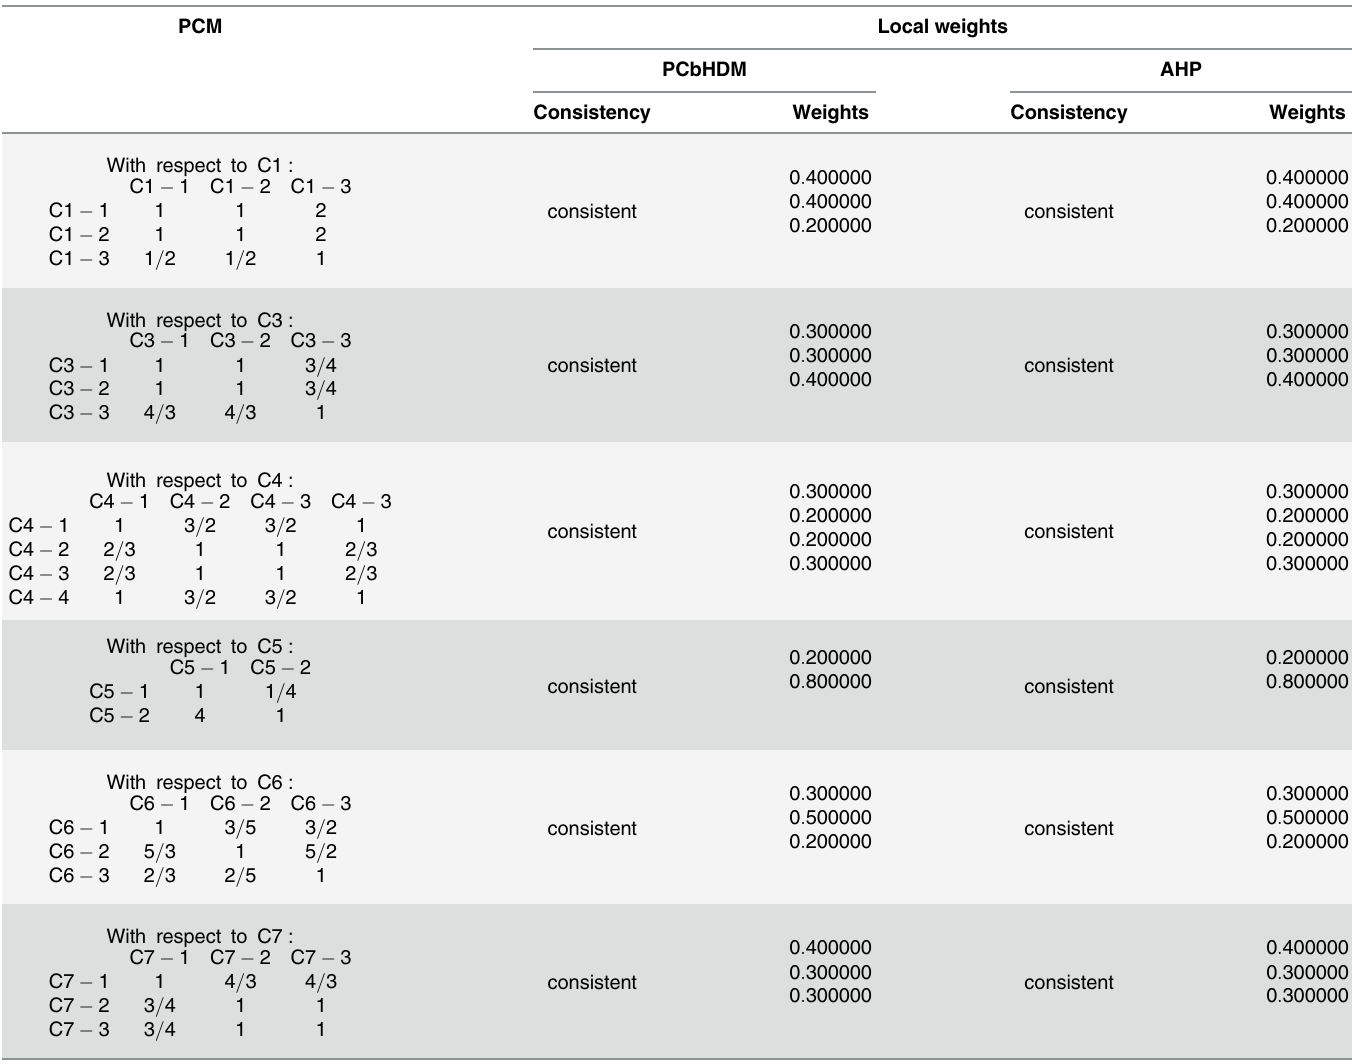
Table 3. PCMs of sub-criteria with respect to criteria and local weights. PCM Local weights PCbHDM AHP Consistency Weights Consistency